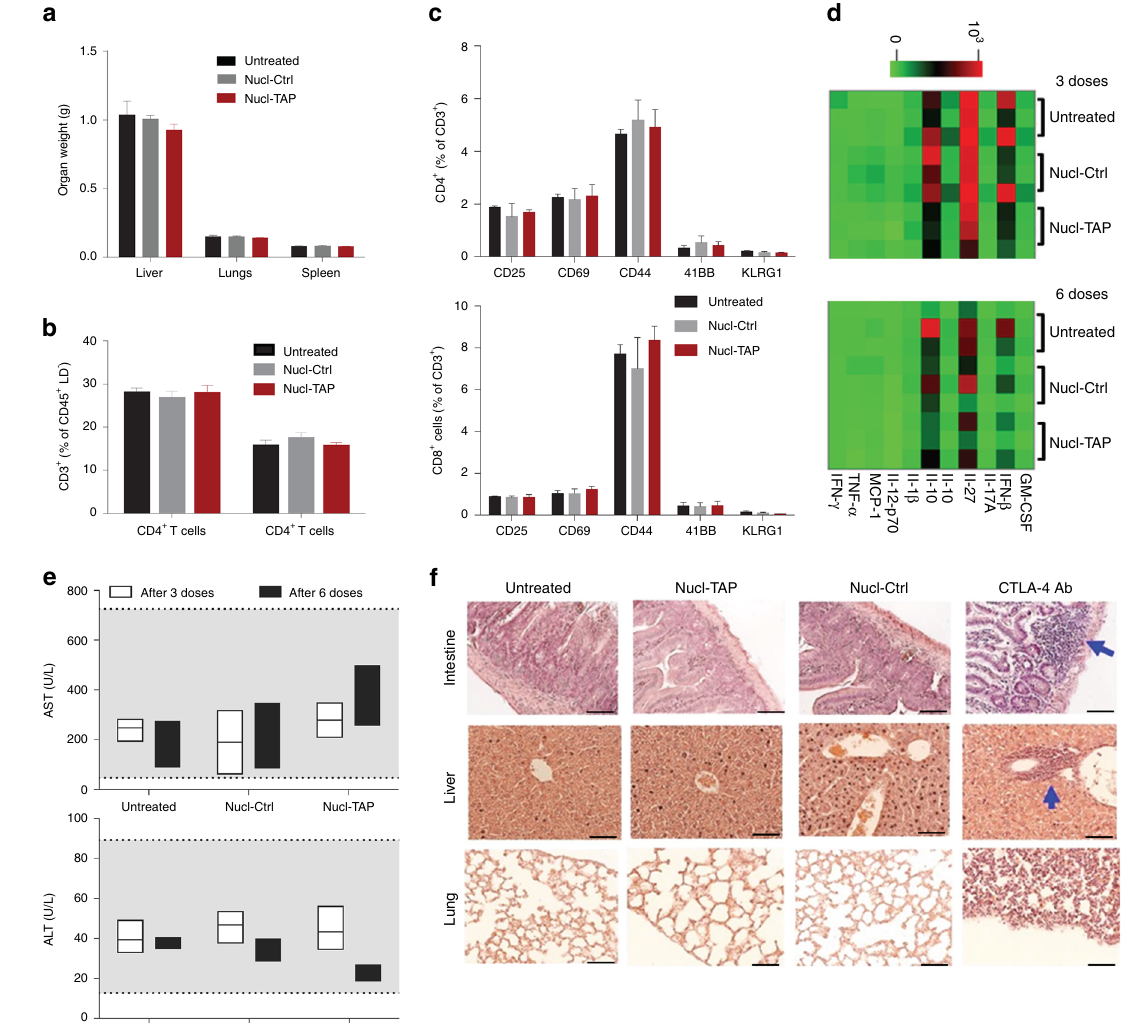
Fig. 5 Toxicity in mice treated with Nucl-TAP. Balb/c mice (8 mice/group) were administered with Nucl-TAP or Nucl-Ctrl, six times every 3 days, except for the immunohistochemistry analysis (panel f ) where mice were treated three times. Two days post last administration mice were sacri fi ced and analyzed. a Organ weight. b CD4/CD8 T cell ratio in the spleen. c Activation markers expressed on CD4 + and CD8 + T cells isolated from the spleen. Data represent means and SEM. d Cytokine levels in the serum of mice after three or six administrations of Nucl-TAP. Heatmap shows log-transformed cytokine concentration values for the experimental groups (3 mice/group). e Liver pathology. ALT and AST in the circulation were determined by ELISA after three or six administrations of Nucl-TAP. Shaded area represents normal levels of ALT or AST in Balb/c mice (from The Jackson Laboratories (MPD, http:// phenome.jax.org/)). Data represent box plot analysis. f In fl ammatory responses in tissue sections stained with hematoxylin and eosin and visualized by light microscopy at ×40 magni fi cation (scale bar: 25 µ m). One group of mice was also treated with 200 µ g of CTLA-4 Ab that elicits a comparable antitumor effect 27,41 . Arrows indicate in fl ammatory foci in mice. a – c Statistical analyses using Kruskal – Wallis and Dunn posttest. e Statistical